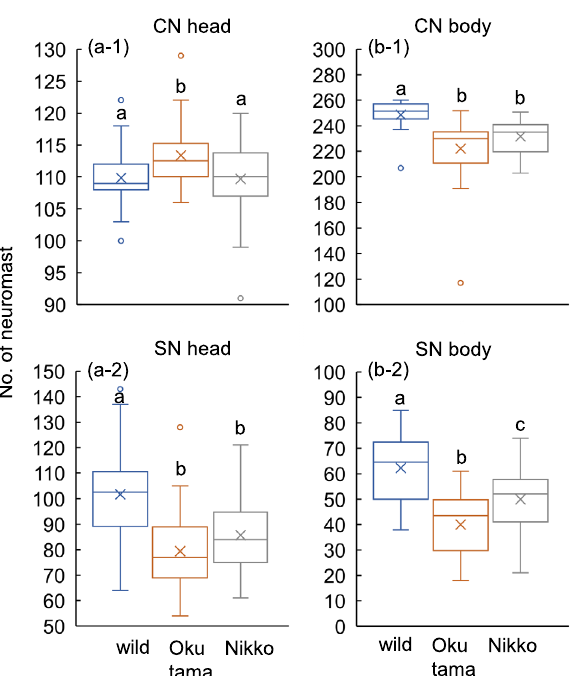
Figure 4. Comparisons of neuromast numbers (CNs and SNs) on the head and body of wild-caught Oncorhynchus masou masou and those reared in the Okutama and Nikko hatcheries. All fish originated from the Okutama fluvial population. Different letters (a, b, c) indicate significant differences detected by Scheffe’s test following univariate ANOVA (p < 0.05). Boxplots show 25, 50 and 75 percentiles, maximum and minimum values without considering outliers, and mean values